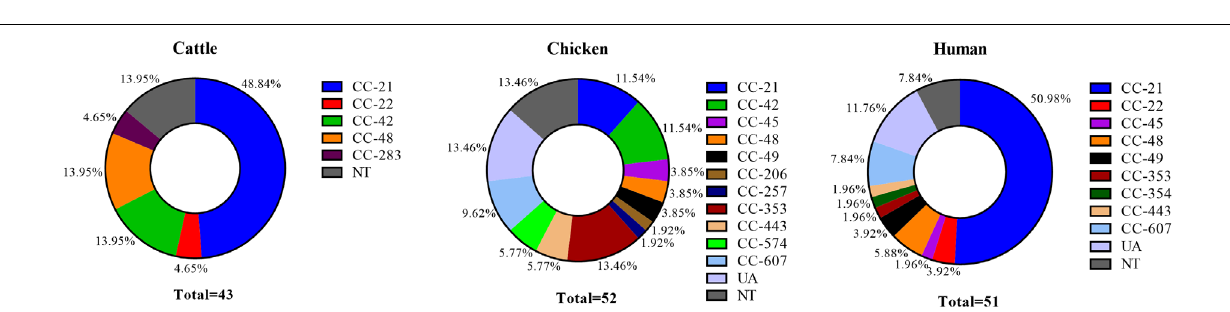
FIGURE 2 | Proportion of MLST clonal complexes in each source. UA, unassigned ST; NT, non-typable ST (including eight different non-typable